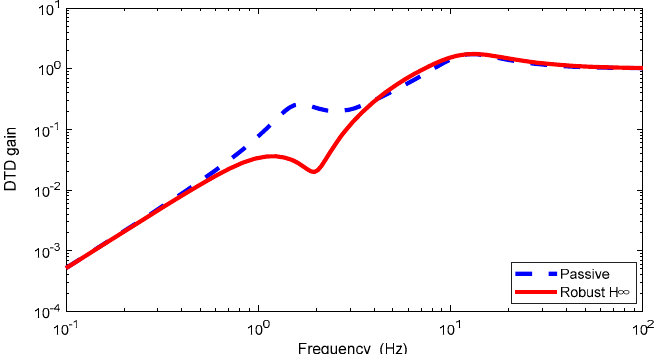
Figure 6. The frequency response of dynamic tire displacement of the closed-loop system.